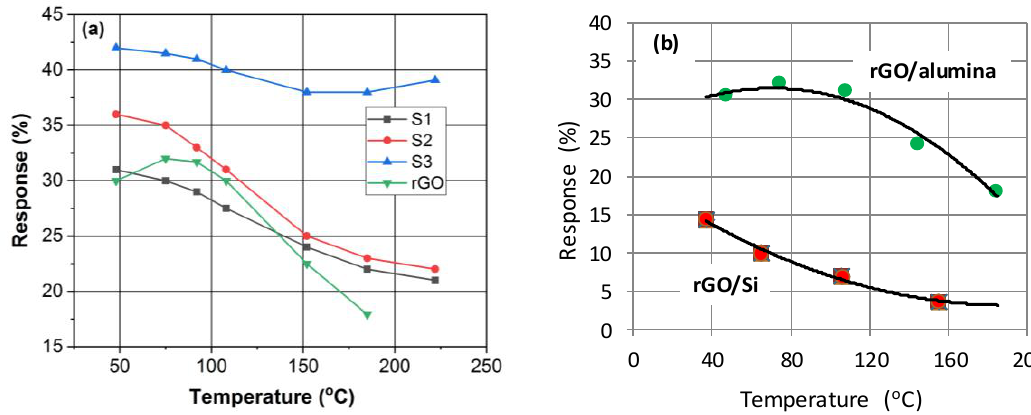
Figure 8. ( a ) Variation of response to 4 ppm NO 2 vs. temperature for multilayer rGO / CuO 4LbL structures (S1–S3) with changing CuO thickness and for a single rGO sample. ( b ) Comparison of responses to NO 2 for rGO samples deposited on both alumina and Si/SiO 2 substrates.